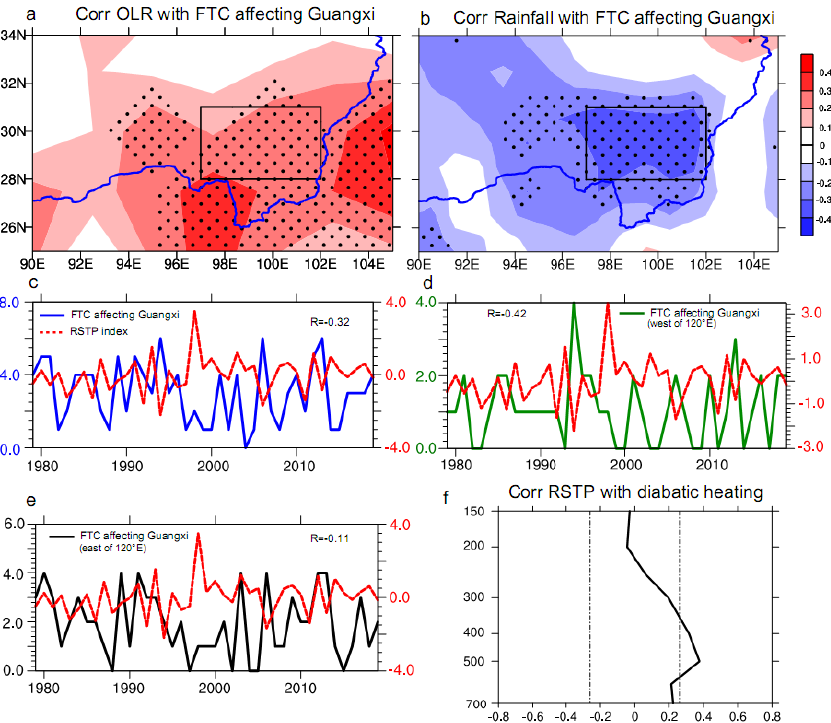
Figure 2. Correlations of ( a ) OLR (unit: W m − 2 ) and ( b ) rainfall (unit: mm day − 1 ) over the southeast TP with FTC affecting Guangxi in boreal summer for 1979–2019. Dotted areas indicate values exceeding 90% confidence level. ( c ) The time series of normalized RSTP (red line) and FTC affecting Guangxi (blue line) during 1979–2019. As ( c ), but for FTC affecting Guangxi generated in the west of 120° E (green line) and FTC affecting Guangxi generated in the east of 120° E (black line) in ( d , e ). ( f ) Correlations of diabatic heating (K day − 1 ) over southeast TP (black box in ( a ) and ( b ): 28° N – 31° N, 97° E – 102° E) with RSTP.